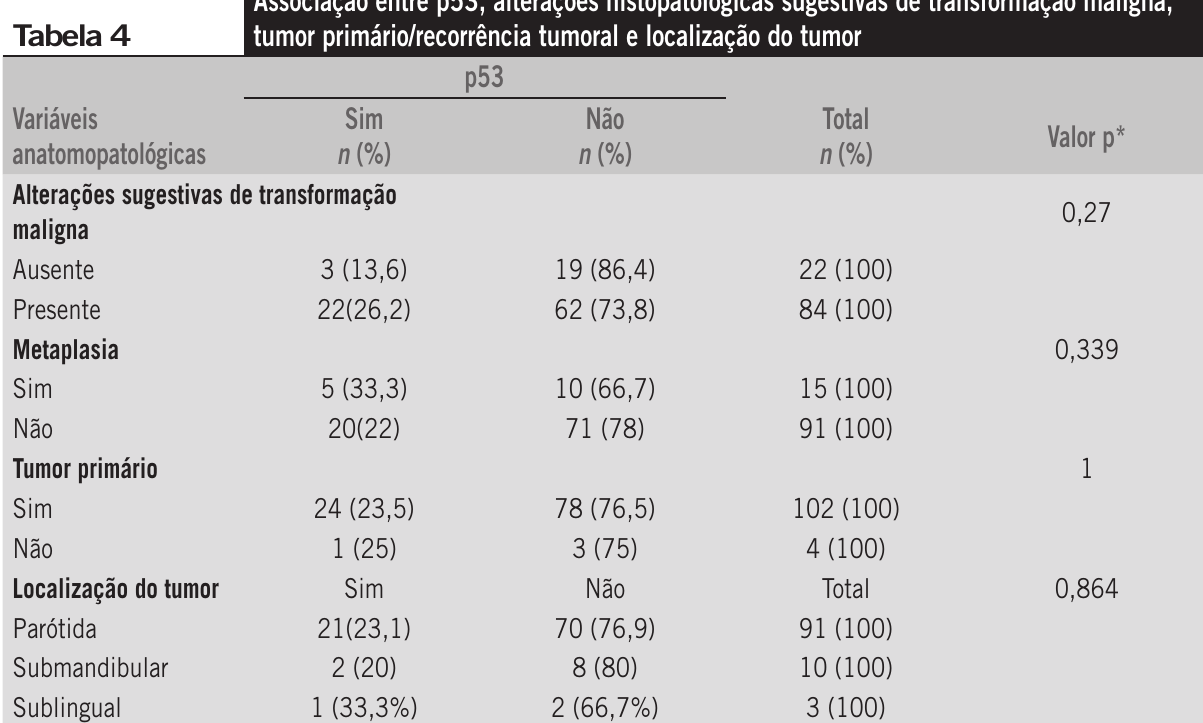
Associação entre p53, alterações histopatológicas sugestivas de transformação maligna, tumor primário/recorrência tumoral e localização do